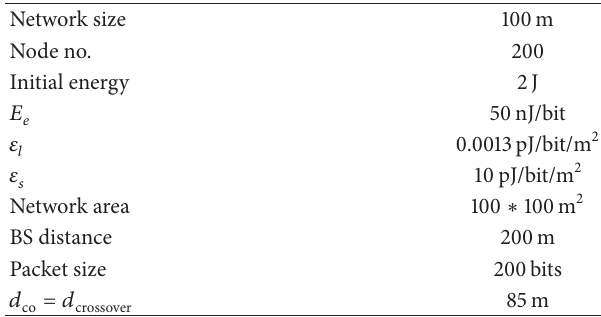
Table 1: Simulation parameters.